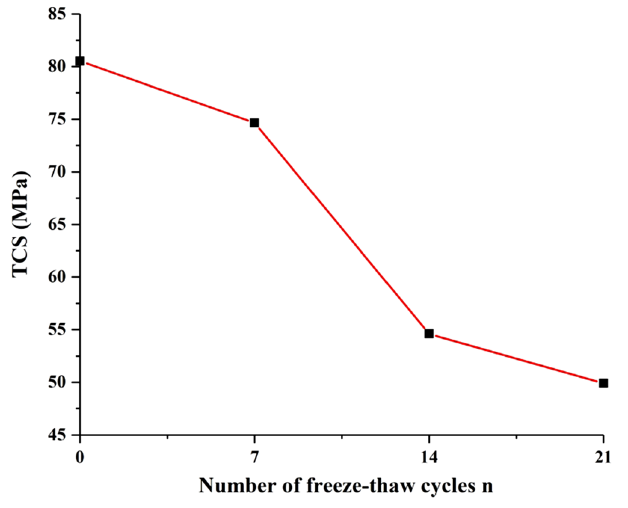
Figure 6. TCS of sandstone with different freeze–thaw